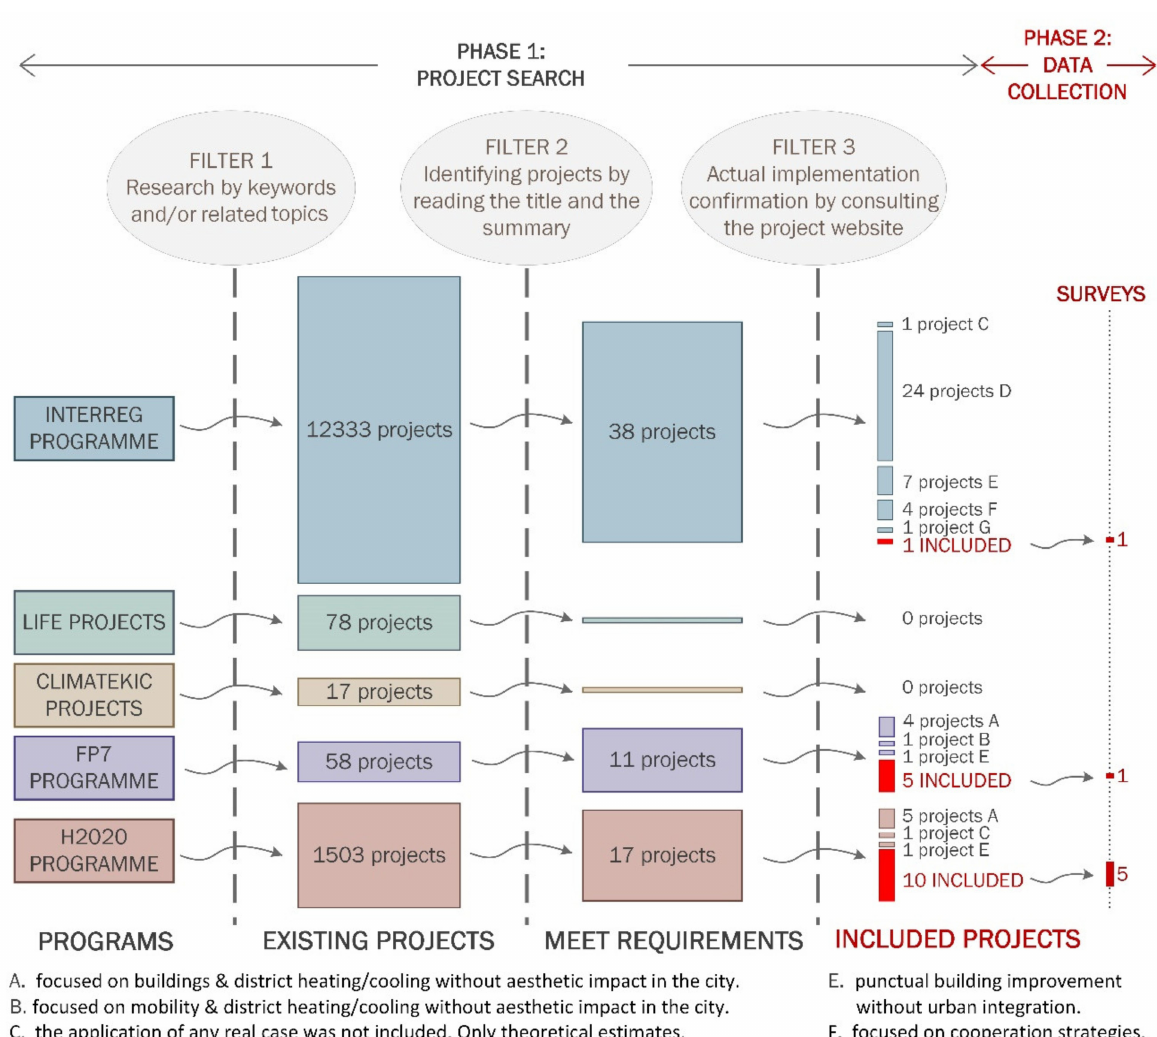
Figure 1. Method of the research carried out in two phases. Phase 1: application of three successive filters to identify the URIPs. Phase 2: data collection through a survey. Letters A to G: reasons for rejecting a project in phase